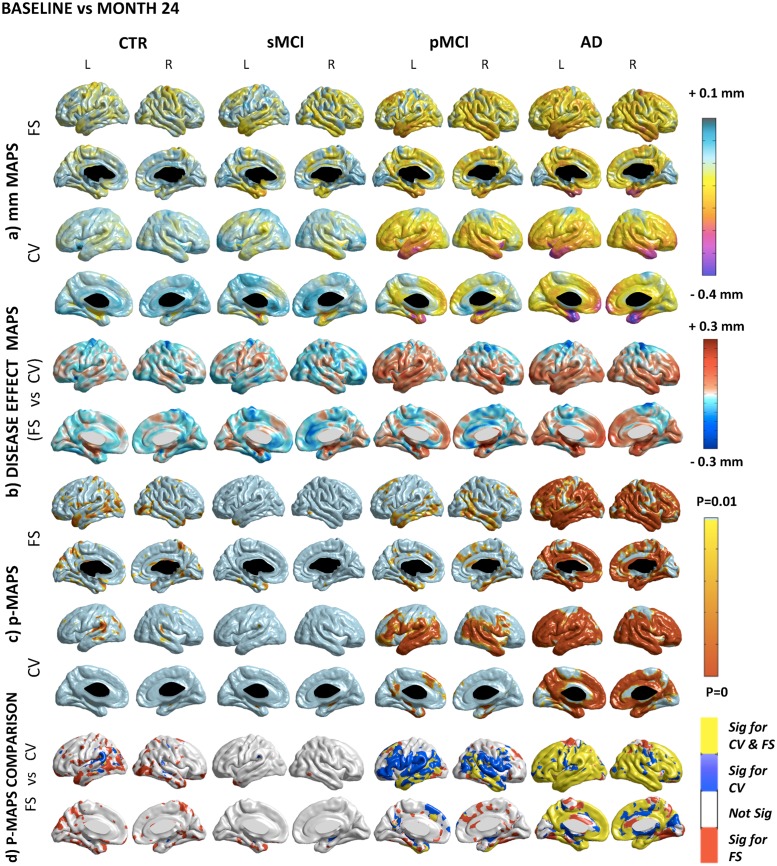
Longitudinal comparison.A) Absolute difference maps (mm) in each group. In CTR and sMCI, both pipelines report a very mild and widespread cortical thinning rate in the motor, somatosensory, verbal and visual association cortex. In pMCI, the atrophy peaks at rates around 0.3 mm in the medial temporal cortex, temporal-parietal-frontal neocortices, with sparing of the sensorimotor strip and of the visual cortex. In AD, the atrophy in the same areas accelerates beyond 0.4 mm. B) Disease effect maps. The mean estimate of the longitudinal disease effect in CTR and sMCI as computed by Freesurfer is greater, although Civet shows higher results in few scattered areas. Furthermore, in the entire disease spectrum, Freesurfer exhibited higher disease effect in the motor cortex. In pMCI, Civet exhibits a greater disease effect except for the cingulate gyrus, while in the AD group the exception is represented by the precuneus. C) Statistical difference maps (p<0.01 FDR-corrected). In CTR, Civet detects an atrophic cluster in the angular gyrus; while Freesurfer in the precuneus and in the temporo-occipital lobe. The pattern in sMCI was more reduced than in CTR. In pMCI Freesurfer was not able to find many regions detected by Civet with the same significance and extension (i.e.: orbital, triangulal, and opercular portion of the inferior frontal gyrus, transverse-temporal and mesial part of the superior frontal cortex, inferior parietal cortex, the superior temporal gyrus). Freesurfer was more sensitive in few scattered expected and unexpected regions. For both pipelines, the longitudinal AD shrinkage showed significant areas throughout the temporal, frontal and parietal lobes, consistently with the progression of the disease. Some shrivelling differences were detected in the anterior division of the cingulate, in the limbic lobe and in the cuneus. D) Overlapping and not-overlapping atrophic regions are shown. Significant voxels detected by both pipelines are in yellow; voxels detected only by Civet are in blue; voxels detected only by Freesurfer are in red. CV: Civet; FS: Freesurfer; L: Left hemisphere; R: Right hemisphere; CTR: Normal elderly controls; sMCI: stable MCI; pMCI: progressive MCI; AD: Alzheimer’s Disease.